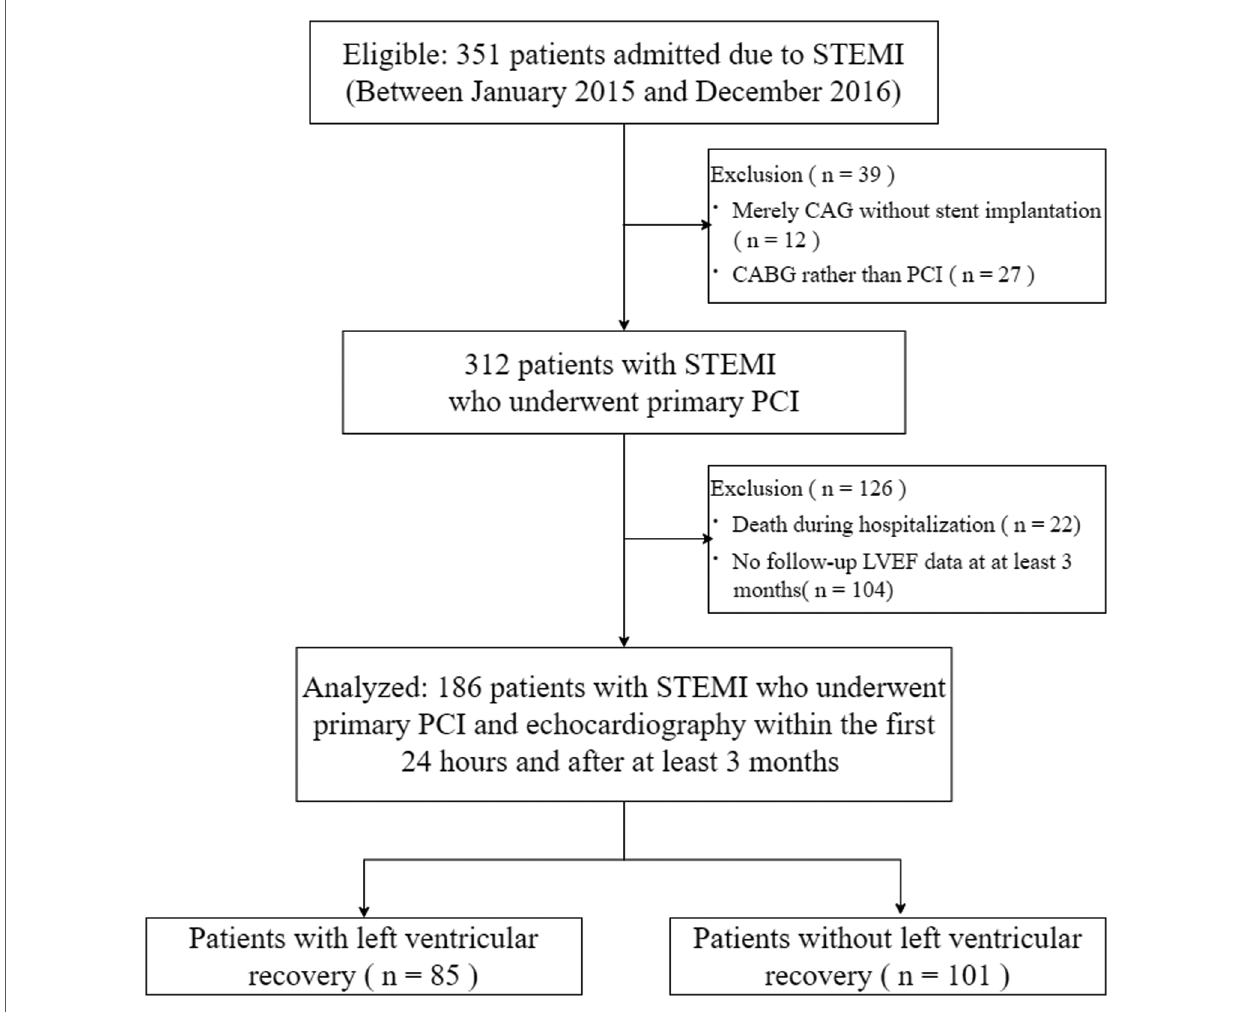
FIGURE 1 Study fl owchart. STEMI, ST-segment elevation myocardial infarction; CAG, coronary angiography; CABG, coronary artery bypass grafting; PCI, percutaneous coronary intervention; LVEF, left ventricular ejection